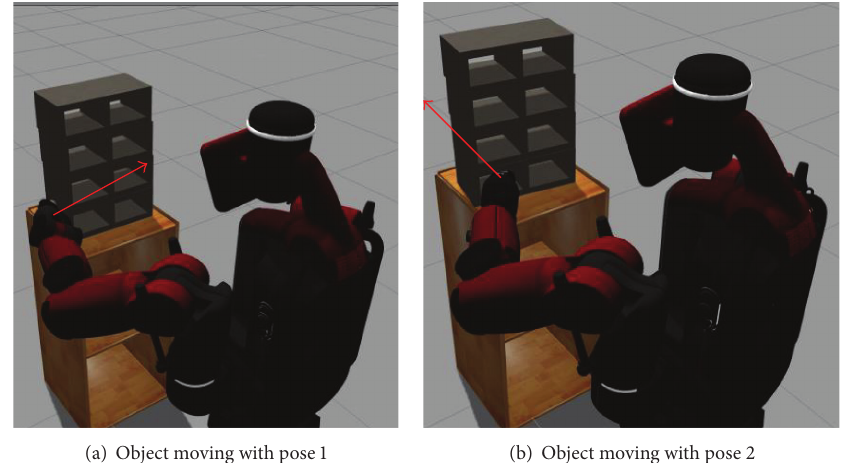
Figure 11: Scheme of Baxter robot moving an object by two different poses. The red arrows denote the force directions of the two poses, respectively.